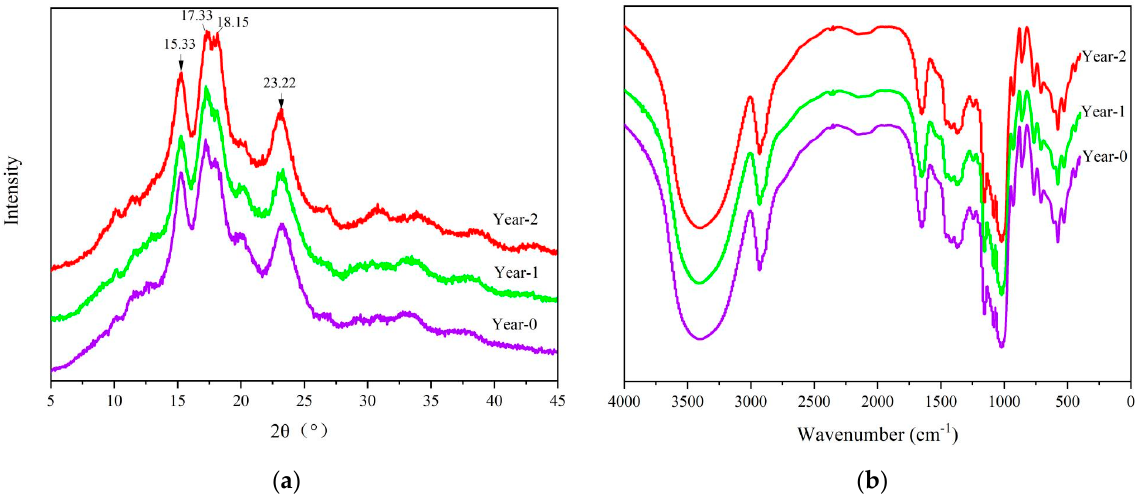
Figure 3. Rice starch variation during storage . ( a ) X-ray diffraction patterns of rice starch at different storage periods; ( b ) Fourier spectra of rice starch at different storage periods.